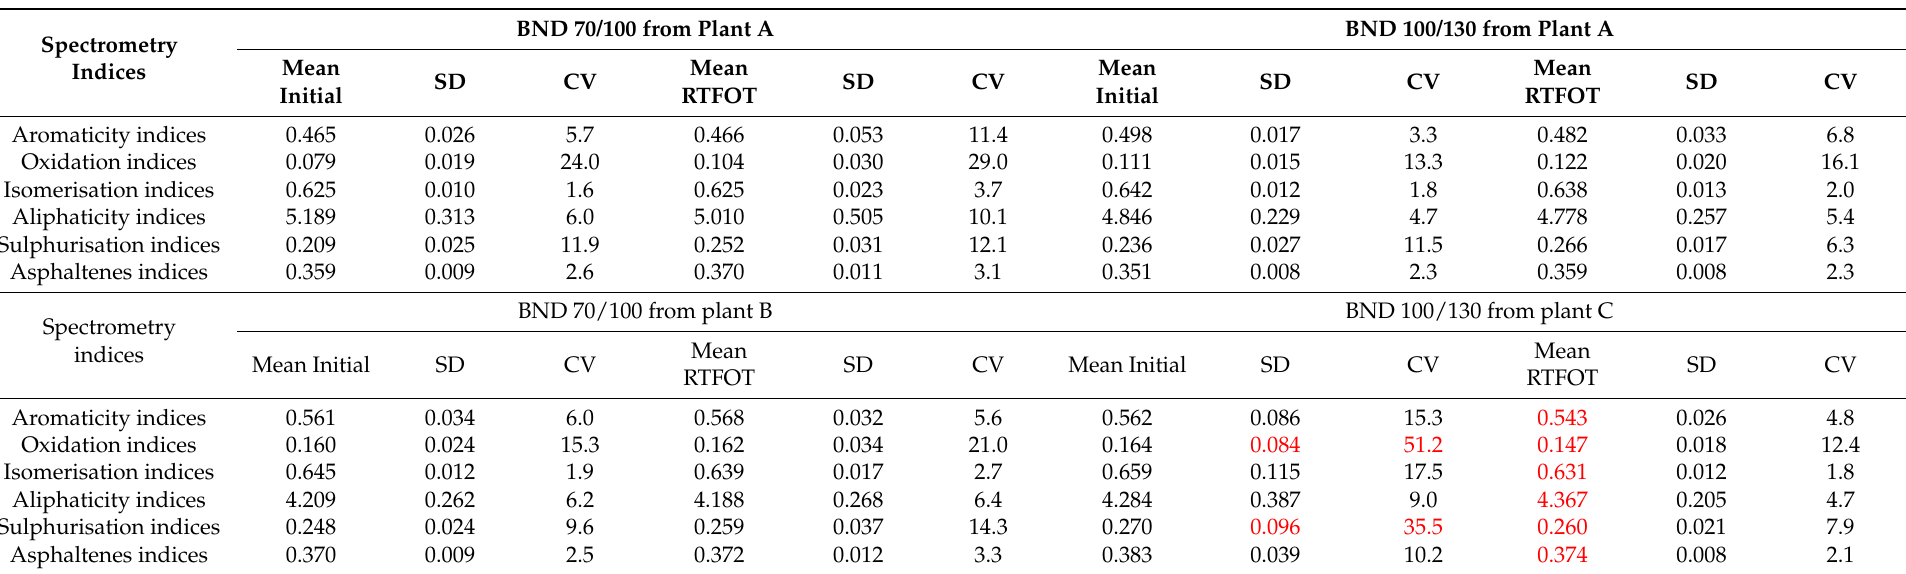
Table 12. The mean of spectrometry indices per plant with their standard deviation (SD) and their variance coefficient